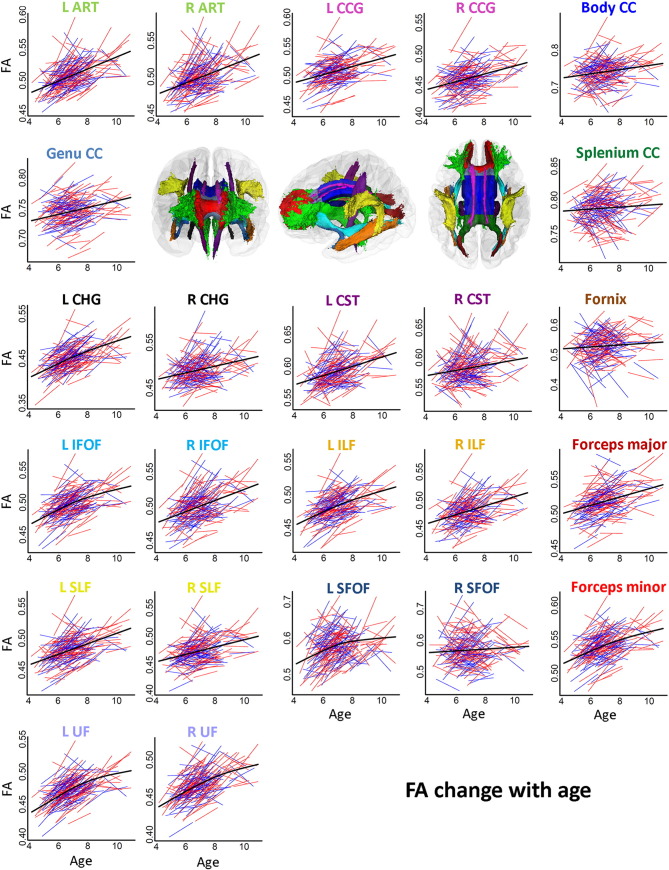
Spaghetti plots of change for FA in specific tracts with age.Spaghetti plots of individual participant change in FA in specific tracts with age (years). Females are plotted in red and males in blue. For each measure, an assumption-free general additive mixed model as a function of age was fitted to accurately describe changes across the age range. Three-dimensional renderings of the probabilistic tracts illustrate fifteen atlas-based probabilistic tracts from the Mori atlas in anterior, left, and dorsal views, displayed on a semitransparent template brain from FreeSurfer (fsaverage). The color-coded titles for each scatterplot represent the color of each specific WM tract. Color codes refer to: Light green: Anterior thalamic radiation (ATR), Pink: Cingulum-cingulate gyrus (CCG), Blue: Body of corpus callosum (CC Body), Gray-blue: Genu of corpus callosum (CC Genu), Green: Splenuim of corpus callosum (Splenium CC), Black: Cingulum-hippocampus gyrus (CHG), Purple: Cortico-spinal tract (CST), Brown: Fornix, Light blue: Inferior fronto-occipital fasciculus (IFOF), Orange: Inferior longitudinal fasciculus (ILF), Dark red: Forceps major, Yellow: Superior longitudinal fasciculus (SLF), Dark blue: Superior fronto-occipital fasciculus (SFOF), and Blue-purple: Uncinate fasciculus (UF). The 3D figures were made by the use of Slicer (http://www.slicer.org/).